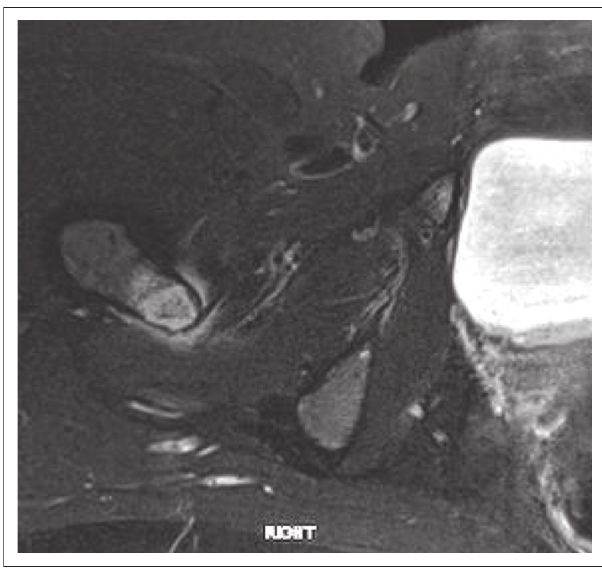
FIGURE 2: Axial T2-weighted MR image of the right hip.